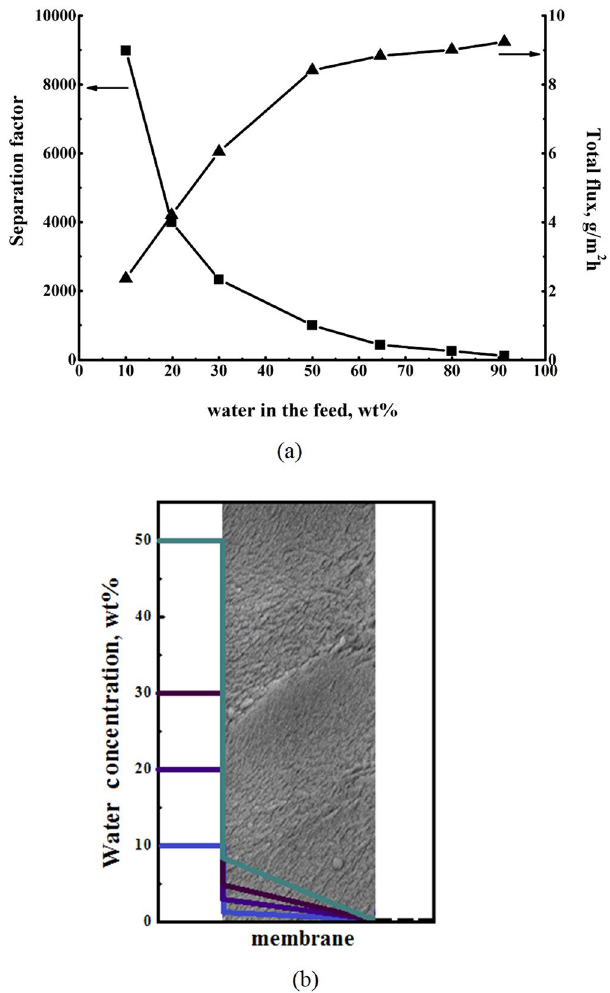
Figure 4. The dependence of separation factor and total flux on the feed composition in pervaporation of water–isopropanol ( a ) and the calculated concentration profile of water through the PAIU membrane ( b ).